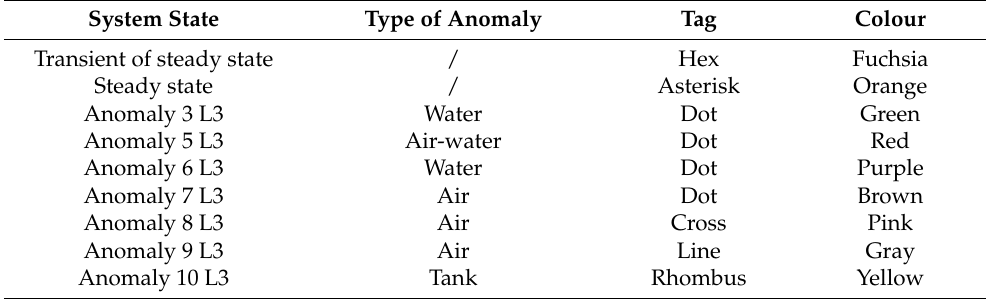
Table 4. Legend of SOM output